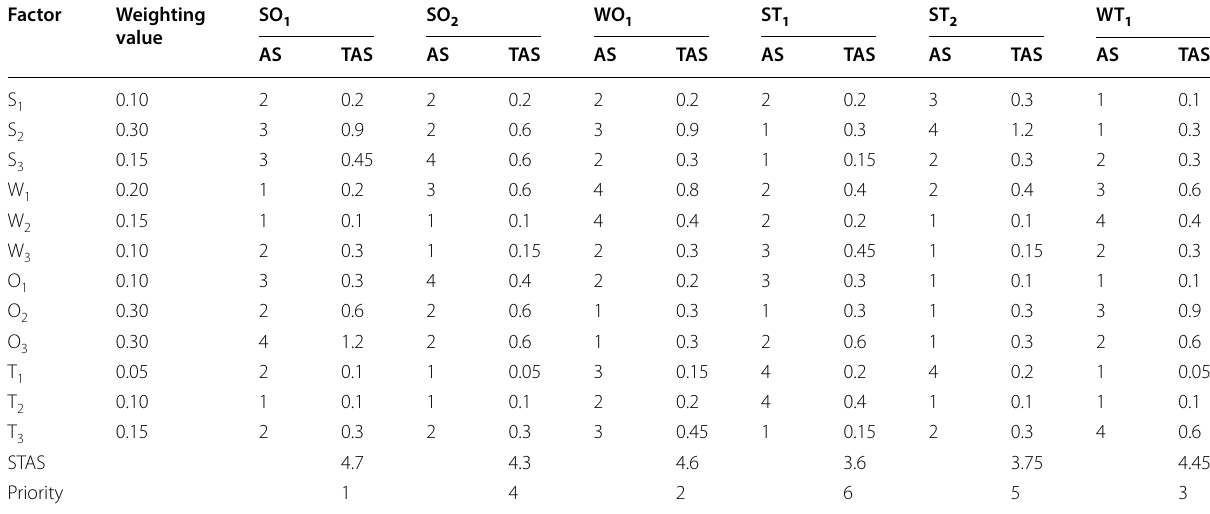
Table 11 QSPM analysis of key